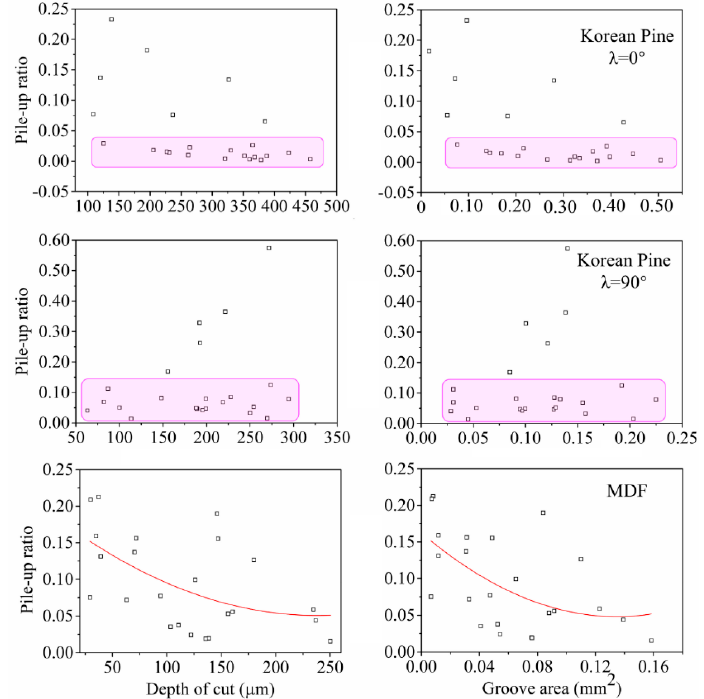
Figure 9. The effects of depth of cut and groove area on pile-up ratio.